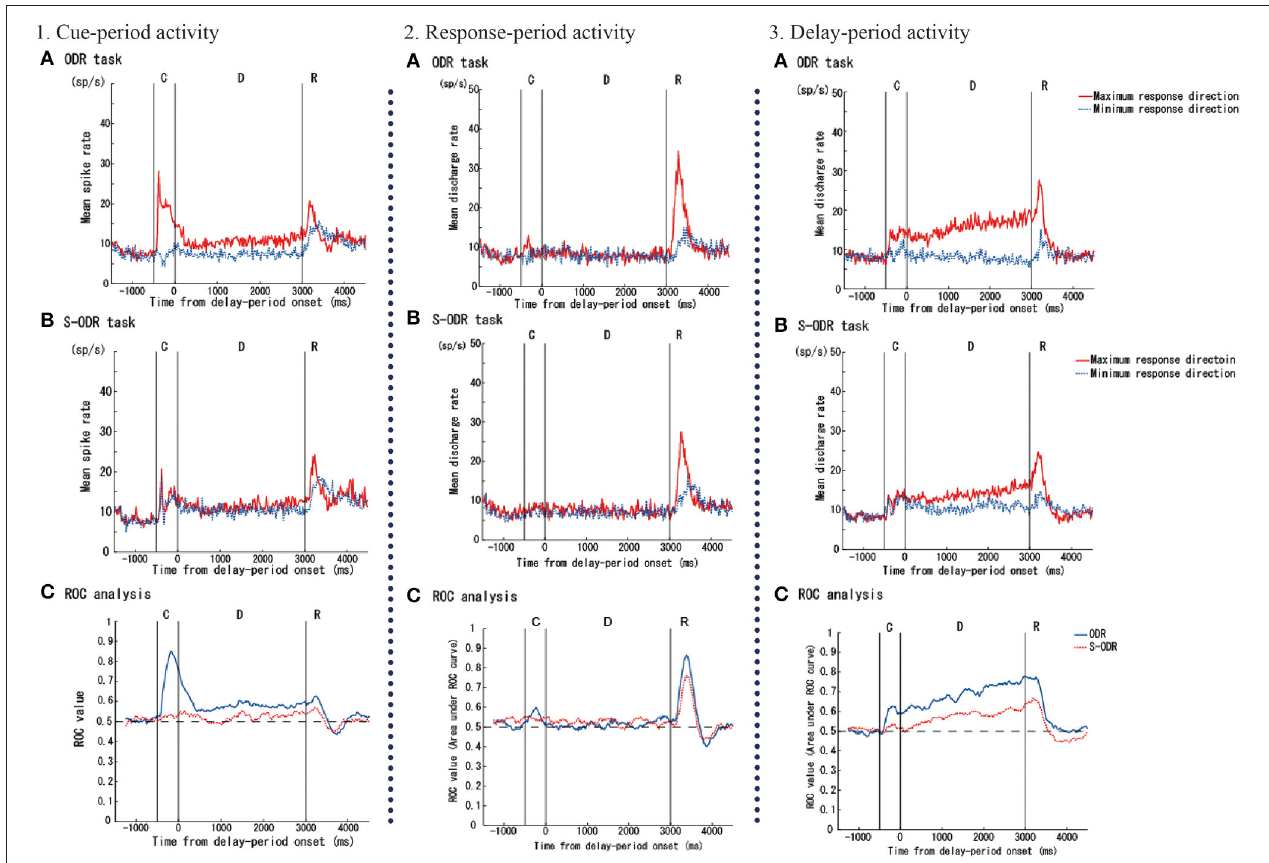
FIGURE 3 | Examples of three kinds of task-related prefrontal activities (cue-, response-, and delay-period activities) observed while monkeys performed an ordinary oculomotor delayed-response (ODR) task (ODR task) and a free-choice ODR task (S-ODR task). In figures showing neural activities in the ODR task (A) and S-ODR task (B) , red lines indicate the activity when the visual cue was presented at the neuron’s best (or maximum response) direction in the ODR task and when the monkey selected the neuron’s best direction in the S-ODR task, while blue lines indicate the activity when the visual cue was presented at the neuron’s worst (or minimum response) direction in the ODR task and when the monkey selected the neuron’s worst direction in the S-ODR task. The bottom three figures (C) show the results of the ROC analysis comparing the differences in prefrontal activity between the best direction and the worst direction in the two task conditions (blue, ODR task; red, S-ODR task). C, D, and R indicate the cue-period, the delay period, and the response period, respectively. The lengths of the cue and delay periods were 500 and 3,000ms, respectively. Figures are reproduced from Watanabe et al. (2006) with permission from the copyright